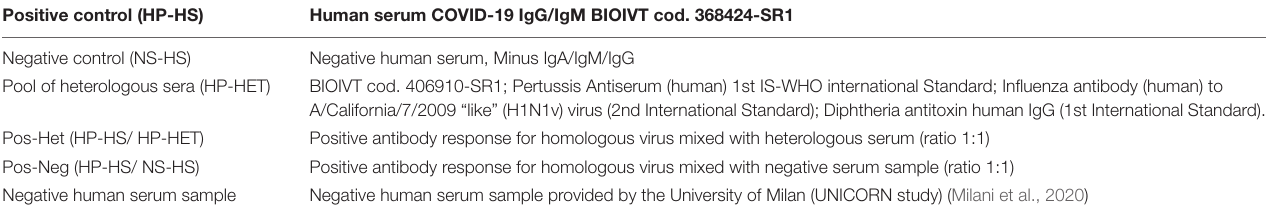
TABLE 1 | Serum samples and controls used to evaluate specificity